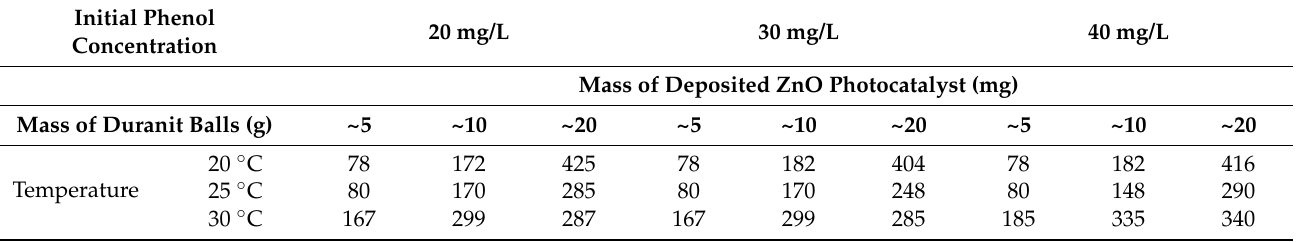
Table 2. 1st cycle of photo-degradation batch tests.